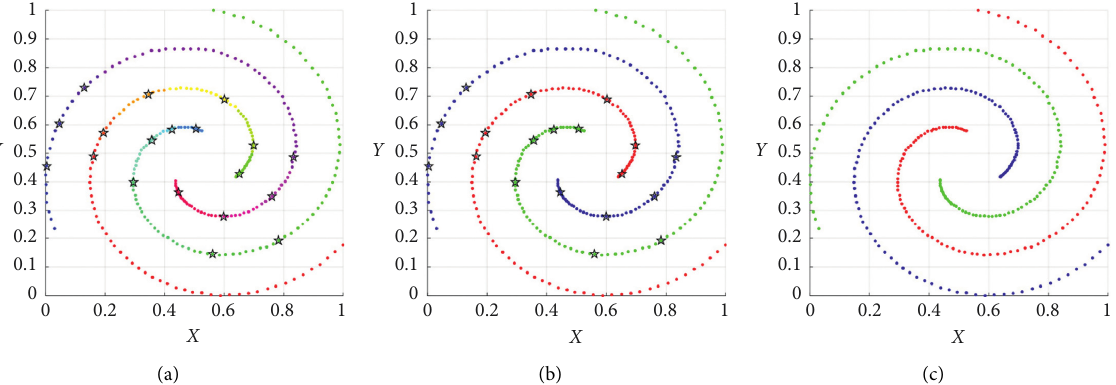
Figure 6: The clustering results of the Spiral dataset. The diverse colors present different NNEGs, and the stars mark the zero samples. (a) NNEGs of spiral. (b) DPC-NNEG on spiral. (c) Ground truth.